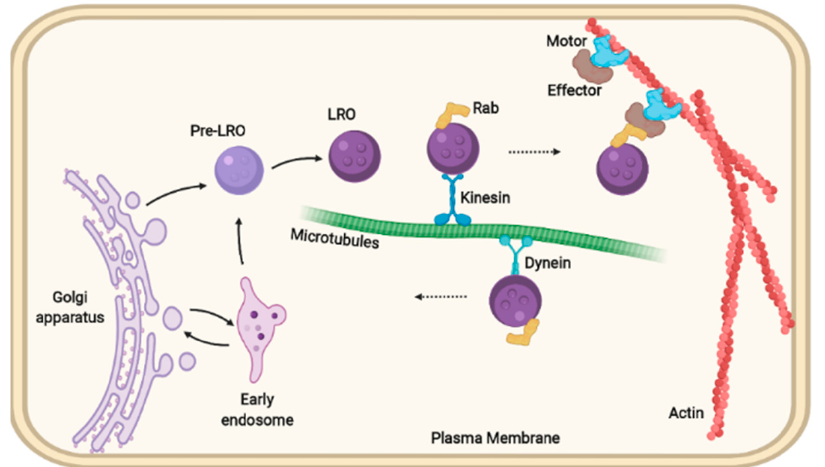
Figure 2. Intracellular delivery of lysosome-related organelles. Mature lysosome-related organelles (LROs) require specific components of the intracellular machinery (Rabs, SNAREs, effectors, motor proteins, Kinesin, Dynein) to assist their trafficking through microtubules and the actin cytoskeleton for delivery and secretion.